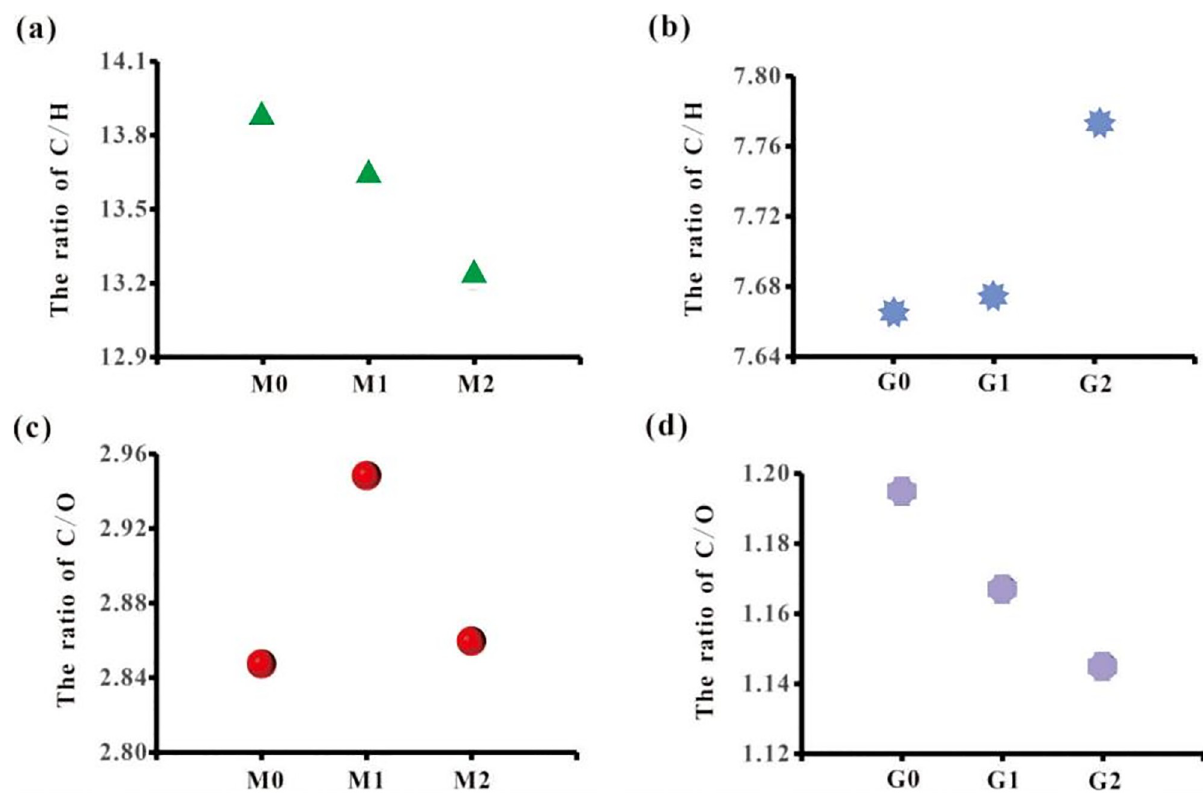
Fig 2. Changes in C/H ratio of lignite (a) and wheat straw (b); changes in C/O ratio of lignite (c) and wheat straw (d).